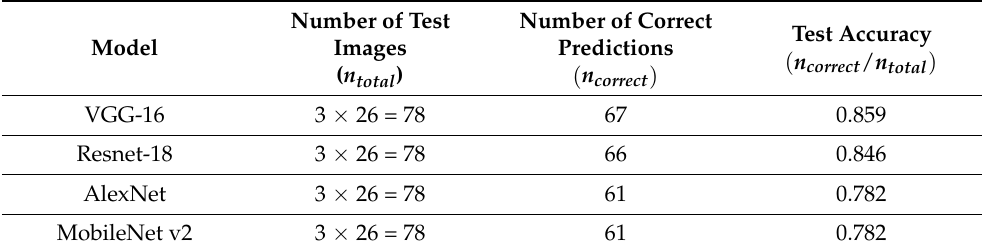
Table 3. Test Accuracy Using Trained